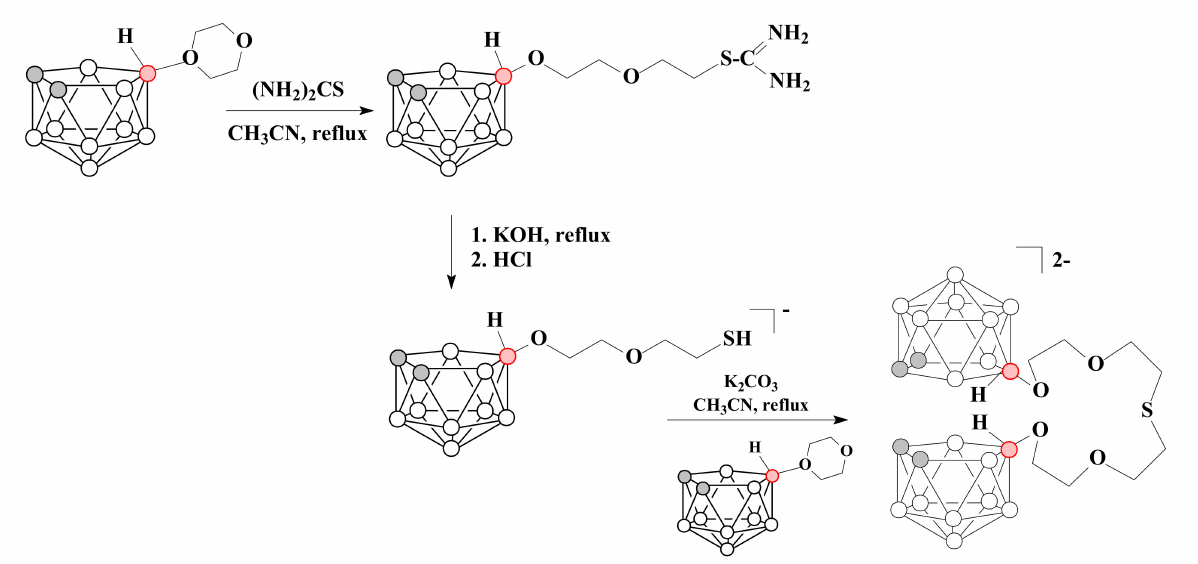
Scheme 10. The reaction of 1,4-dioxane derivative of nido -carborane with thiourea. The nido -carborane thiol [10-HSCH 2 CH 2 OCH 2 CH 2 O-7,8-C 2 B 9 H 11 ] − can also be ob- tained directly by the reaction of 10-O(CH 2 CH 2 ) 2 O-7,8-C 2 B 9 H 11 with excess of aqueous sodium hydrosulfide in tetrahydrofuran. The by-product of this reaction is a thioether [(10-CH 2 CH 2 OCH 2 CH 2 O-7,8-C 2 B 9 H 11 ) 2 S] 2 − [71]. Two nido -carborane-based podands [(10-CH 2 CH 2 OCH 2 CH 2 O-7,8-C 2 B 9 H 11 ) 2 S] 2 − and [1,2-(10-SCH 2 CH 2 OCH 2 CH 2 O-7,8-C 2 B 9 H 11 ) 2 C 6 H 4 ] 2 − were used for the synthesis of crown ethers with the cobalt bis(dicarbollide) fragment incorporated in heteromacrocycle [79] (Scheme